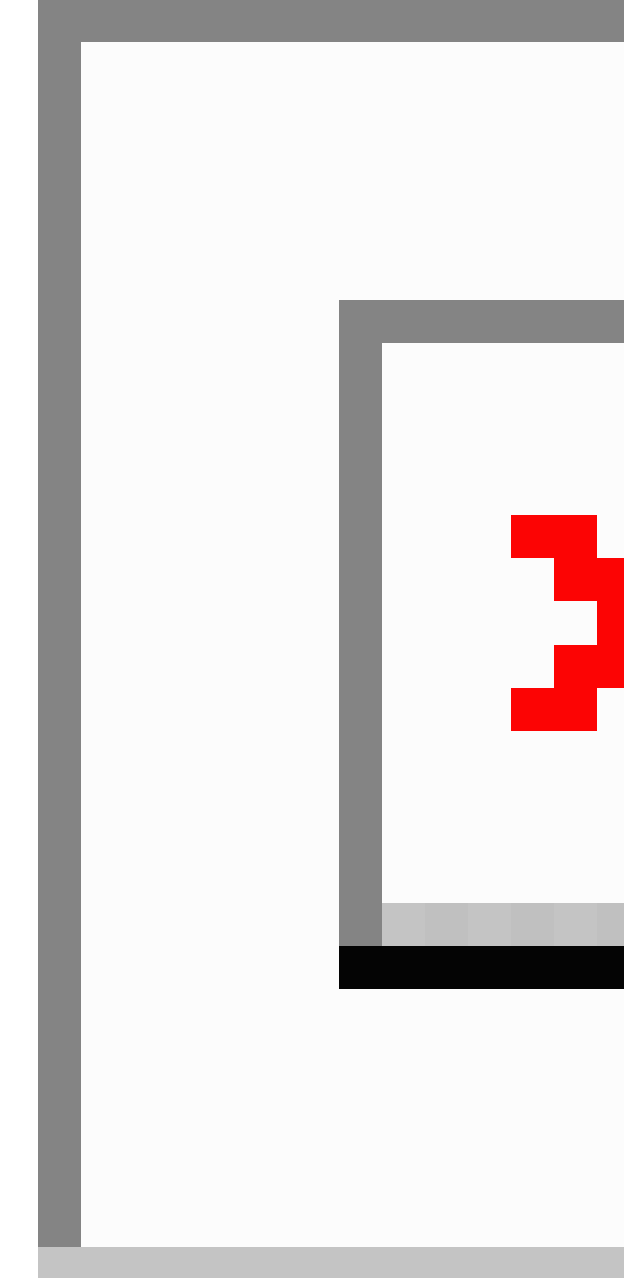
Figure 1. Screenshot of emocha event-contingent